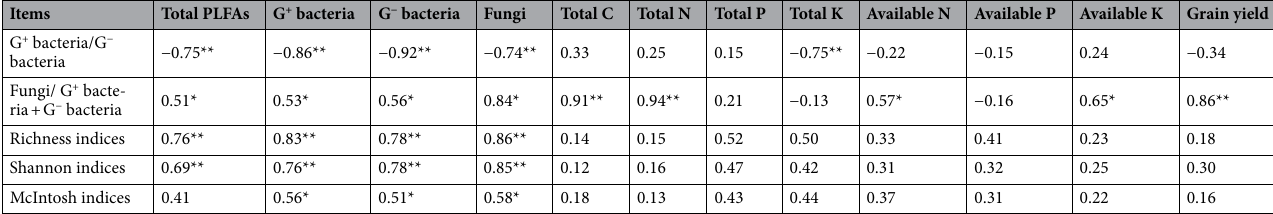
Table 5. Correlation of soil microbial characteristics, microbial diversity indices with soil nutrient and grain yield of rice. **, * were indicated significantly difference at p < 0.05 and p < 0.01 level,